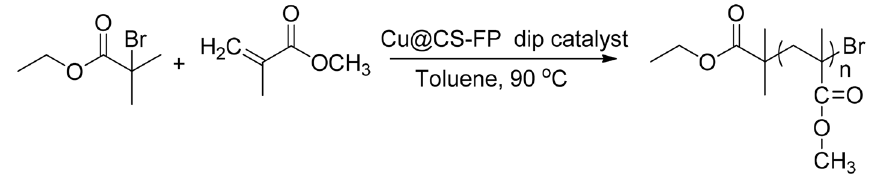
Figure 2. ATRP reaction of methyl methacrylate.